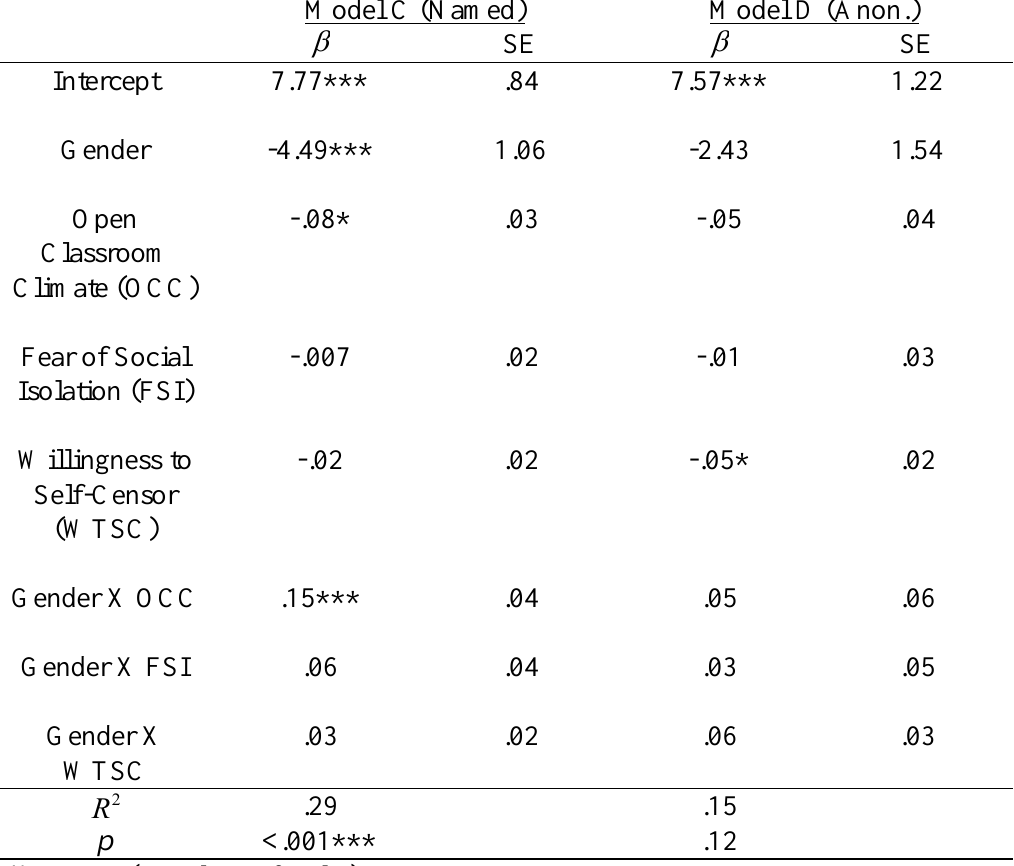
Regression Predicting Total Word Count in Named and Anonymous Online